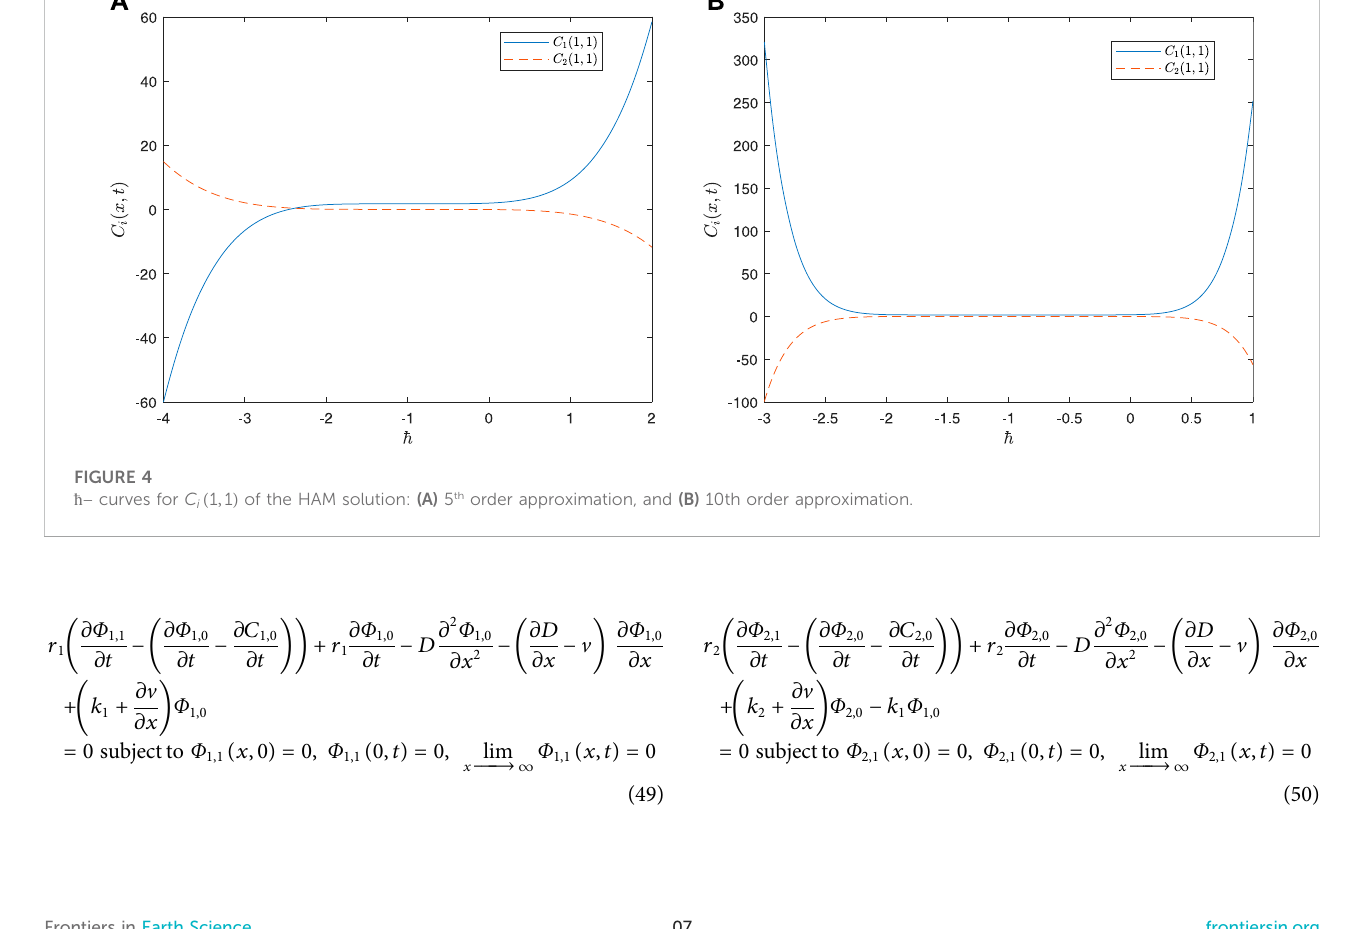
Frontiers in Earth